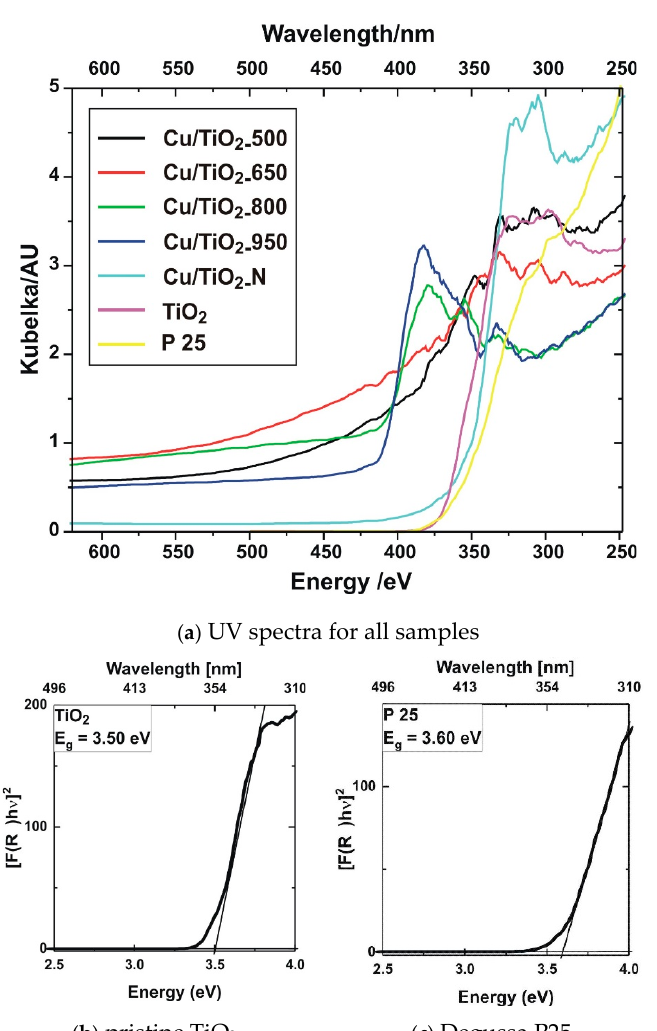
Figure 12. The IR spectra of the examined samples.